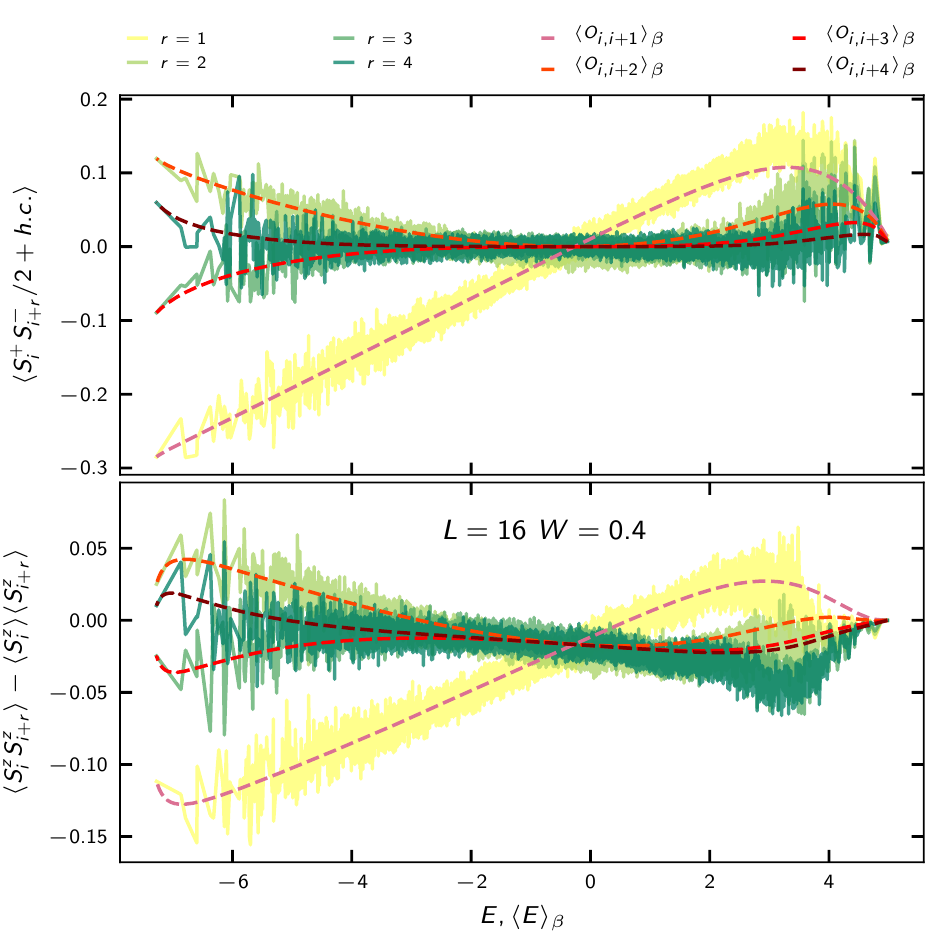
Figure 12: Spin-flip correlator and connected z correlation as function of energy at distance r = 1,2,3,4 in the ETH phase. Both correlations increase linearly with energy at distance r = 1. The spin-flip correlator is constant at larger dis- tances r > 1 whereas the z correlation goes down slightly. The dashed lines are the thermal expectation values in the canonical M = 0 ensemble of the corre- (cid:128) (cid:138) e − β H 〉 = Tr O lators 〈 O plotted vs. the expectation value of the energy β i , i + r i , i + r Z (cid:128) (cid:138) e − β H 〈 E 〉 = Tr H for β ∈ [ − 1000,1000 ] β Z